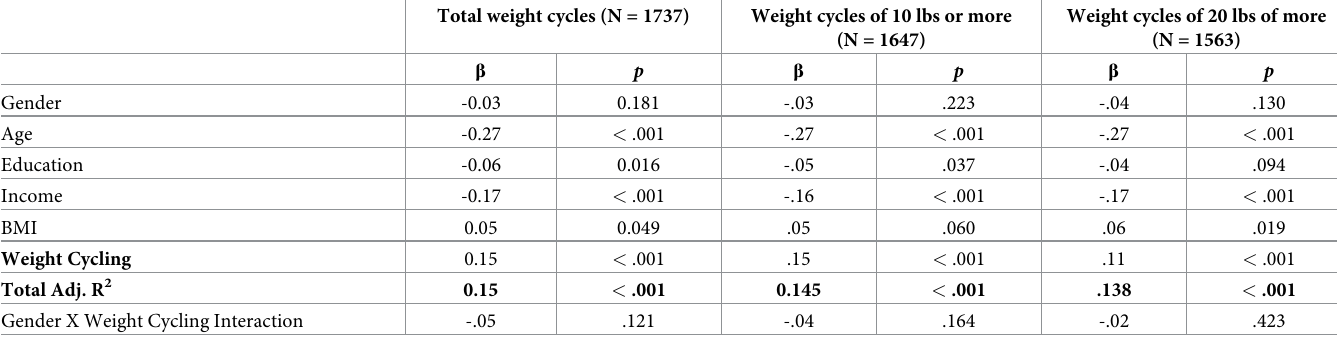
Table 3. Predicting depressive symptoms (CES-D-10) from weight